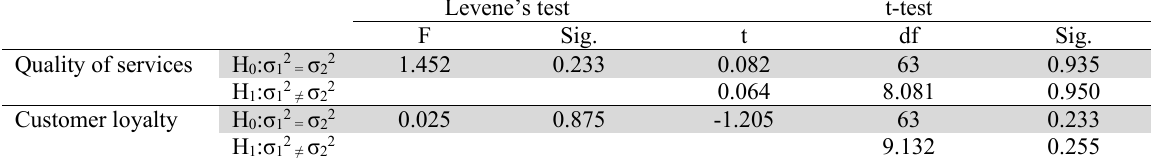
The summary of Levene’s test and t-test on the effects of gender on quality of services and loyalty